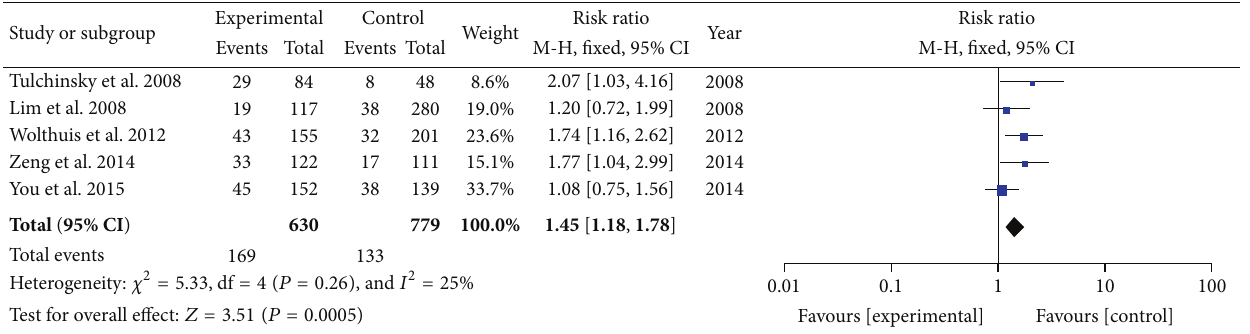
Figure 3: Standard forest plot of the RR for pCR rates comparing longer time intervals with shorter intervals at 7 weeks.